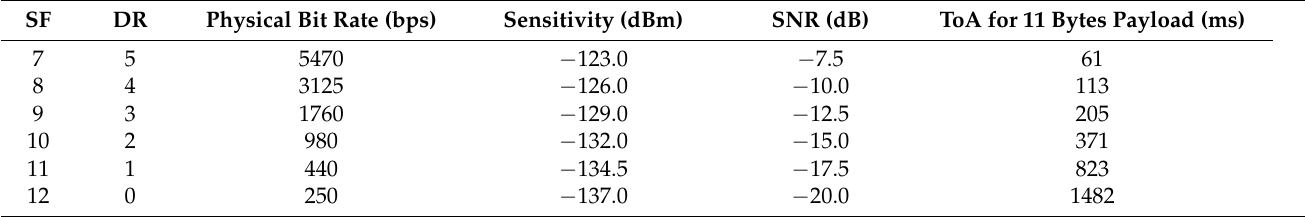
Table 2. LoRa values at 125 kHz [5,26–28].